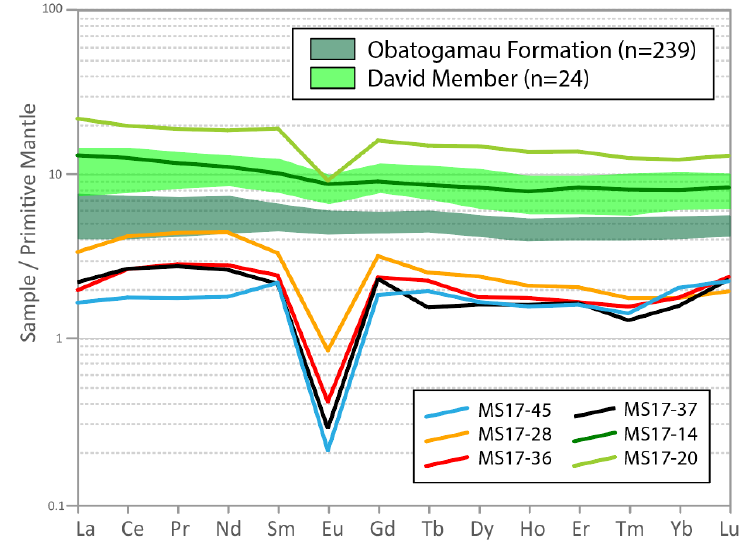
Figure 10. REE diagram normalized to the primitive mantle [42] for whole rock chemical analyses performed on behalf of this study (samples MS17- xx ) and compiled from the MERN dataset (see Figure 1 for reference) (Obatogamau Formation and David Member).